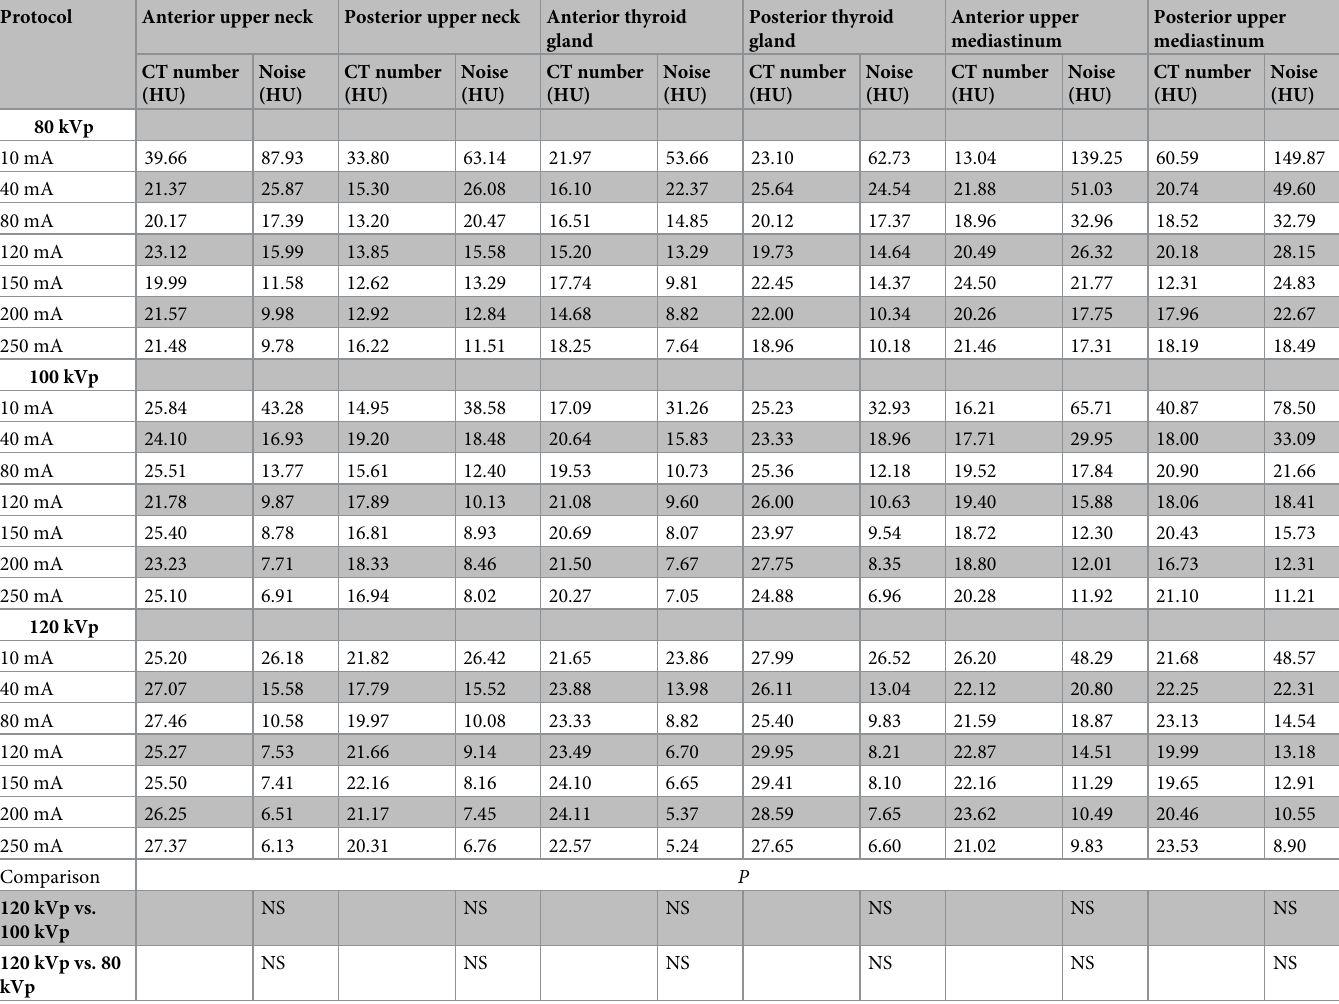
Table 4. Results of objective analyses of reconstruction techniques for computed tomography imaging of simulated neck scans of a child aged 10 years. Protocol Anterior upper